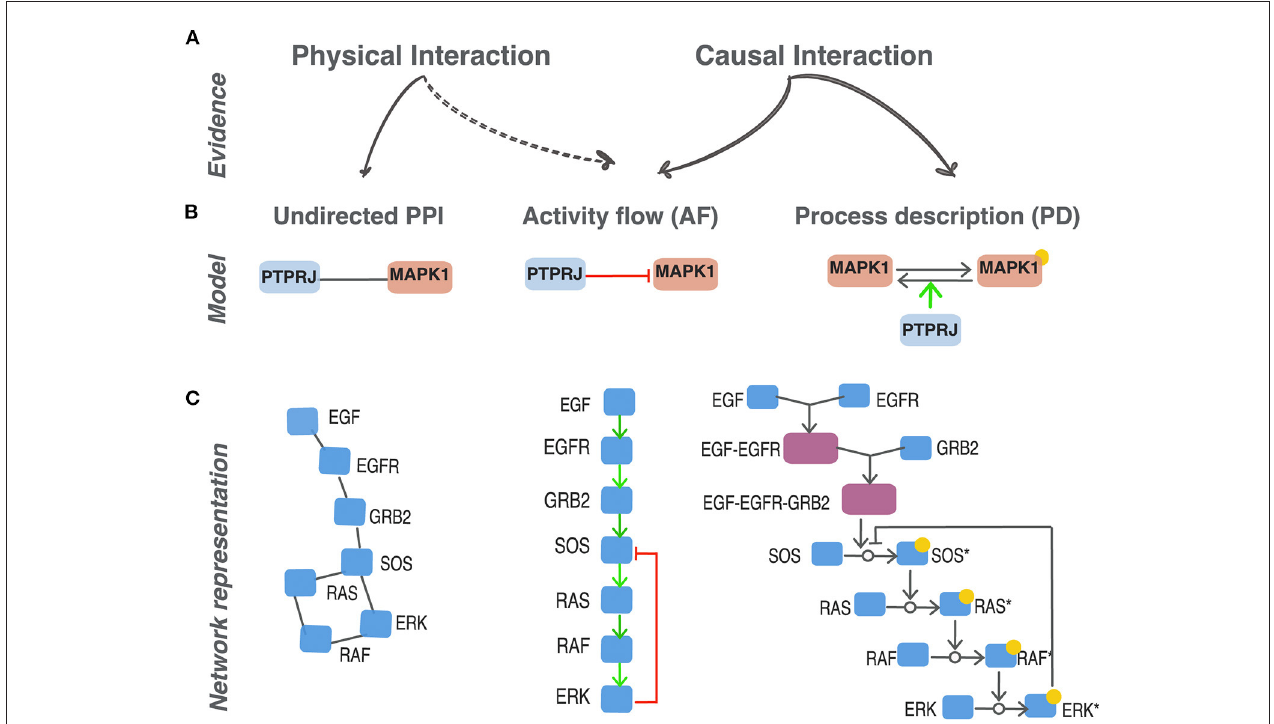
FIGURE 1 | Different representations of protein interactions. (A) Experimental methods can either provide evidence that support a physical contact between two proteins to form a complex (physical interaction) or a modulation of the activity of a target protein caused by the activity of a parent protein (causal interaction). (B) Different graphical representation of the same biological statement: PTPRJ dephosphorylates and inhibits MAPK1 ( Sacco et al., 2009). Three distinct models to represent protein relationships supported by different experimental evidence: undirected PPI, activity-flow and process description. (C) The EGFR signaling pathway represented as an undirected protein-protein interaction network (PPI), as activity-flow network (AF) and a process-description network (PD). *indicates the modified form of a given protein